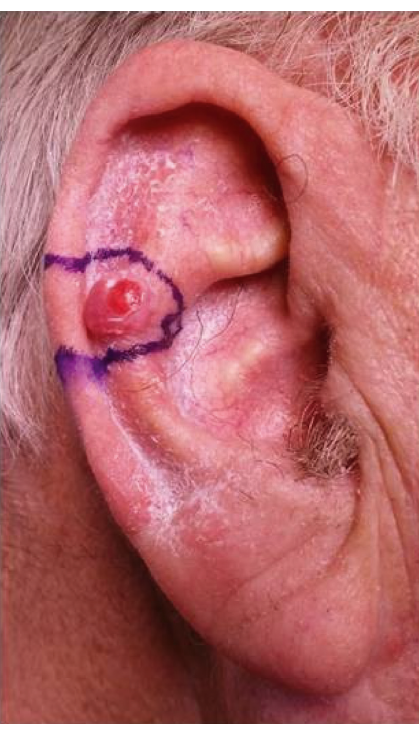
Figure 1: Clinical photograph showing a one-centimetre nodular lesion on the right upper pinna.